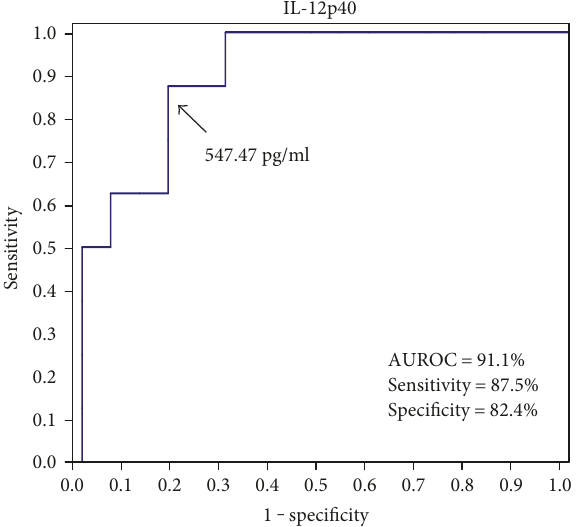
Figure 3: Performance of preoperative serum IL-12p40 in discriminating between BA patients with successful and those with failed Kasai. AUROC: area under receiver-operating characteristic. Table 4: Correlation of IL-2p40 with age, laboratory, and histopathological parameters of the studied